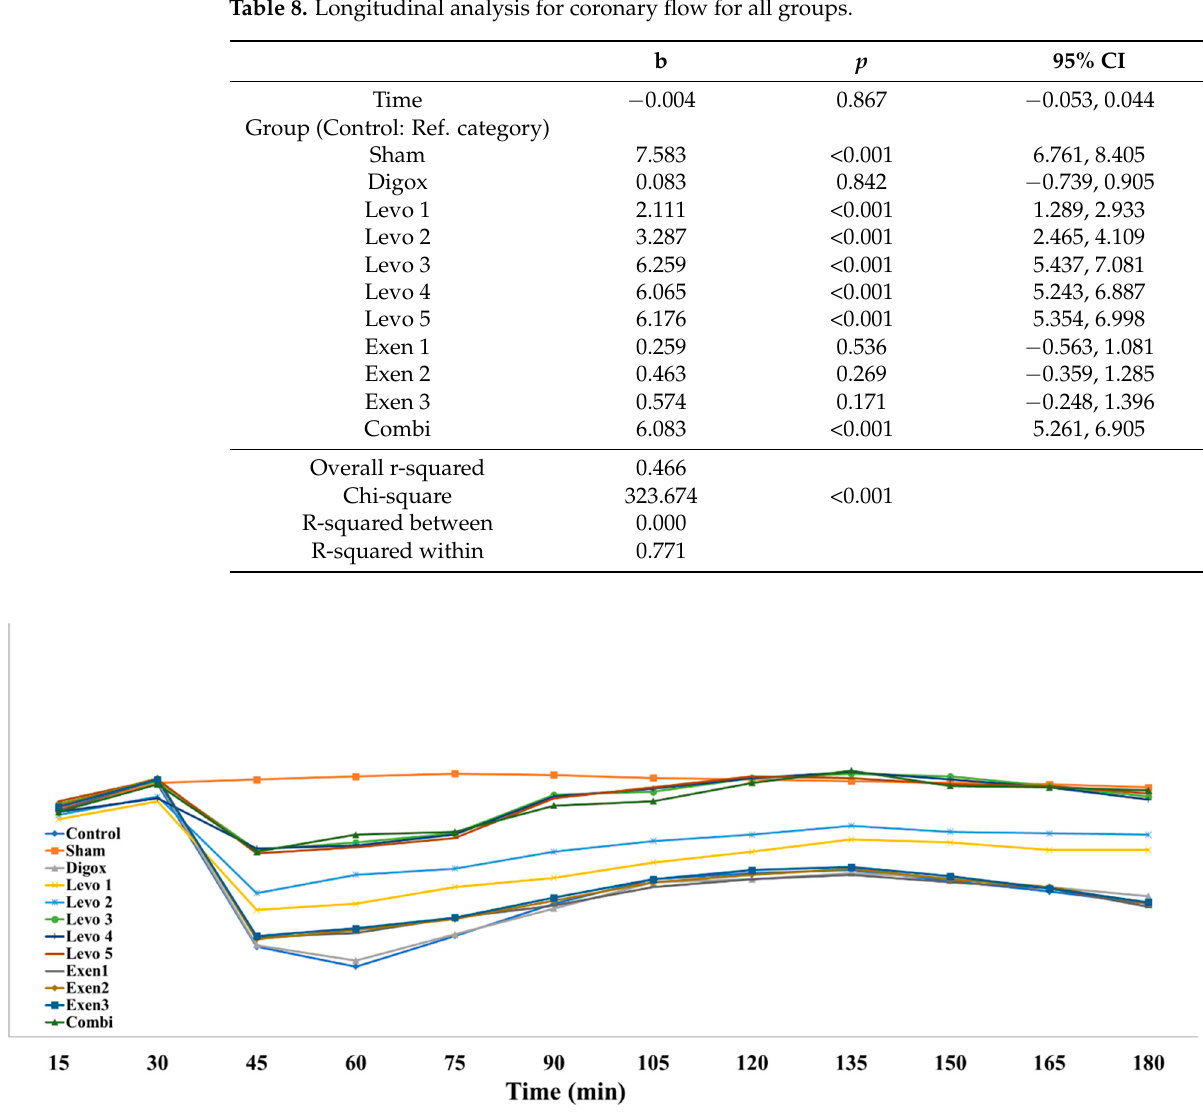
Table 8. Longitudinal analysis for coronary flow for all groups.